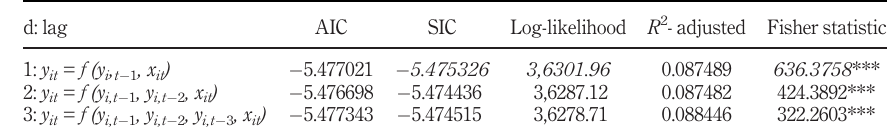
Table V. Optimal lag length of dynamic panel